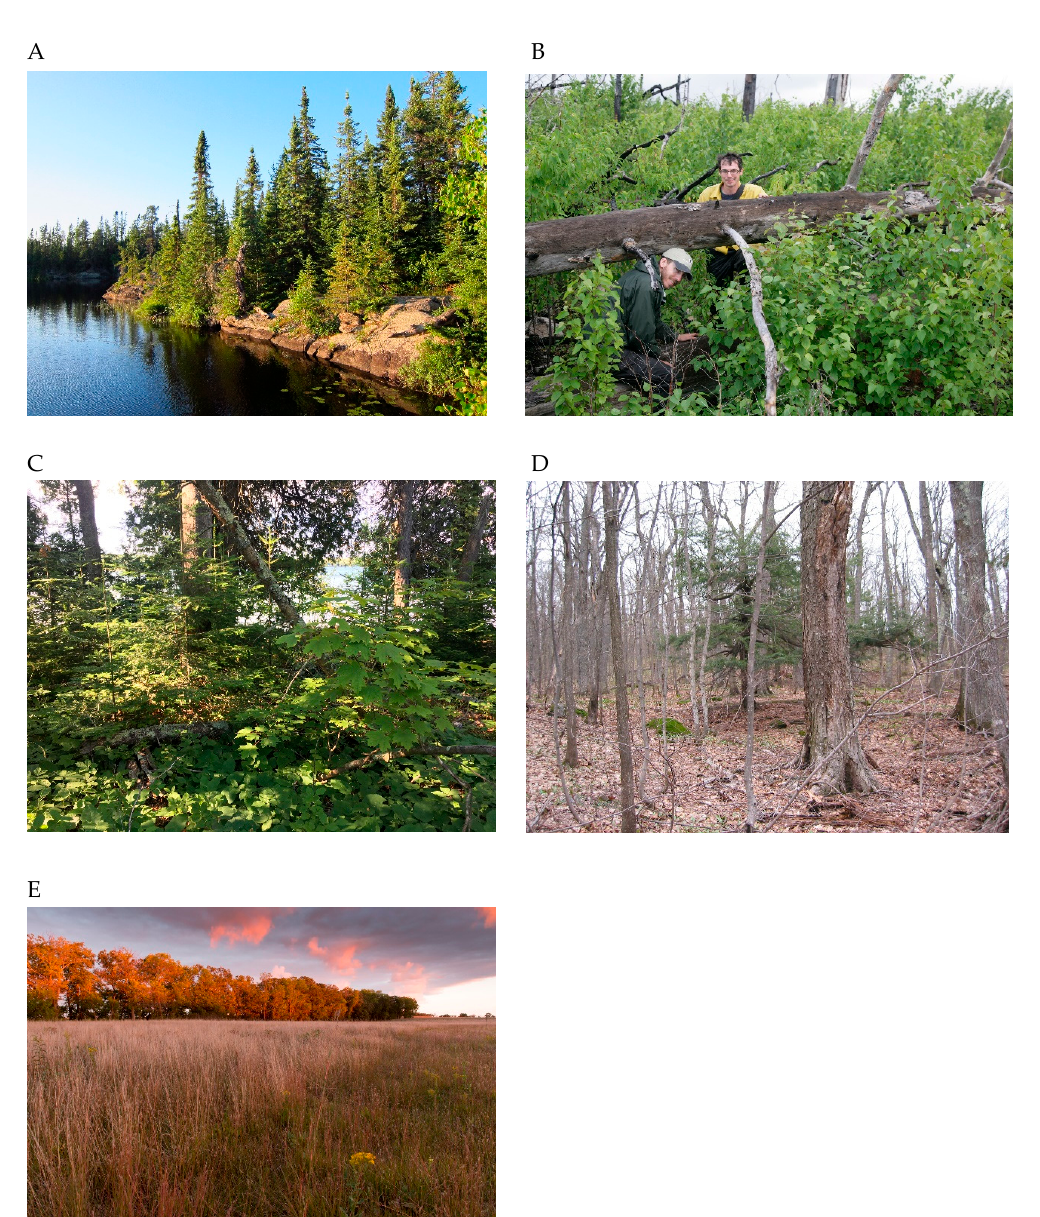
Figure 4. Pre-historic and contemporary transitions of boreal forest in Minnesota and Wisconsin, USA. ( A ) Current boreal forest of black spruce ( Picea mariana (Mill.) Britton, Sterns & Poggenb.) in the Boundary Waters Canoe Area Wilderness, Minnesota. Photo, Elias Anoszko. ( B ) Frame 2 change in a boreal forest. Young paper birch ( Betula papyrifera Marshall) forest in the Boundary Waters Canoe Area Wilderness. This birch regeneration replaced a coniferous, boreal forest of jack pine ( Pinus banksiana Lamb.) and black spruce after a windstorm-fire combination in 1999–2006. Photo by Dave Hansen. ( C ) Frame 2-3 change in progress. Sugar maple sapling growing in a boreal balsam fir ( Abies balsamea (L.) Mill.) and white spruce ( Picea glauca (Moench) Voss) forest in northern Wisconsin in 2017, where there were no maples 40 years prior; this is a Frame 2 setting now, but could become Frame 3 in the future if maple continues to replace conifers. Photo by Lee Frelich. ( D) Frame 3 example—temperate sugar maple forest resulting from mid-Holocene transition of boreal forest in a warming climate in western Upper Michigan. Photo by Kalev Jõgiste. ( E) Frame 4 example—prairie with scattered oak woodland resulting from mid-Holocene transition from boreal forest due to increasing aridity in western Minnesota. Photo by Dave